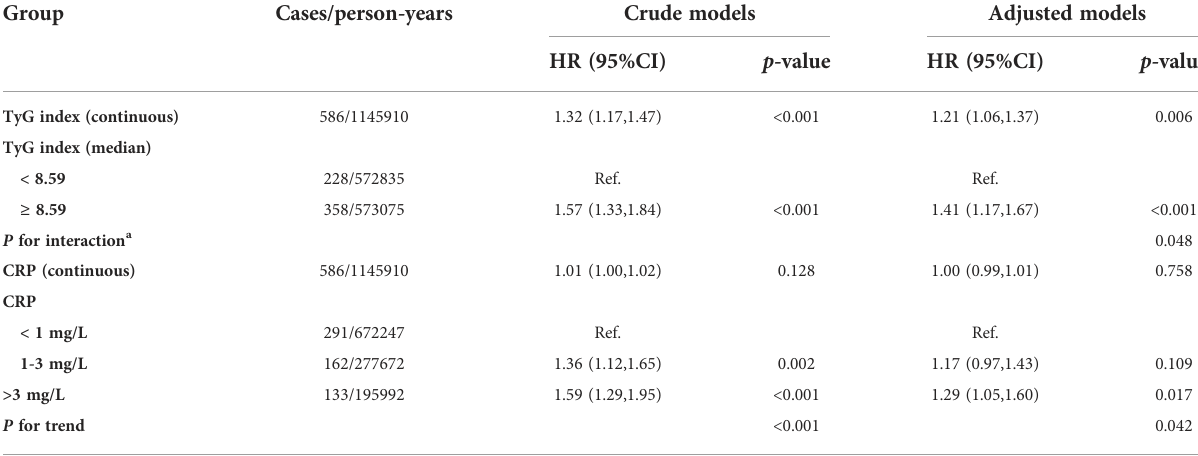
TABLE 3 Hazard ratios (HRs) for the association of TyG index or CRP levels with CRC